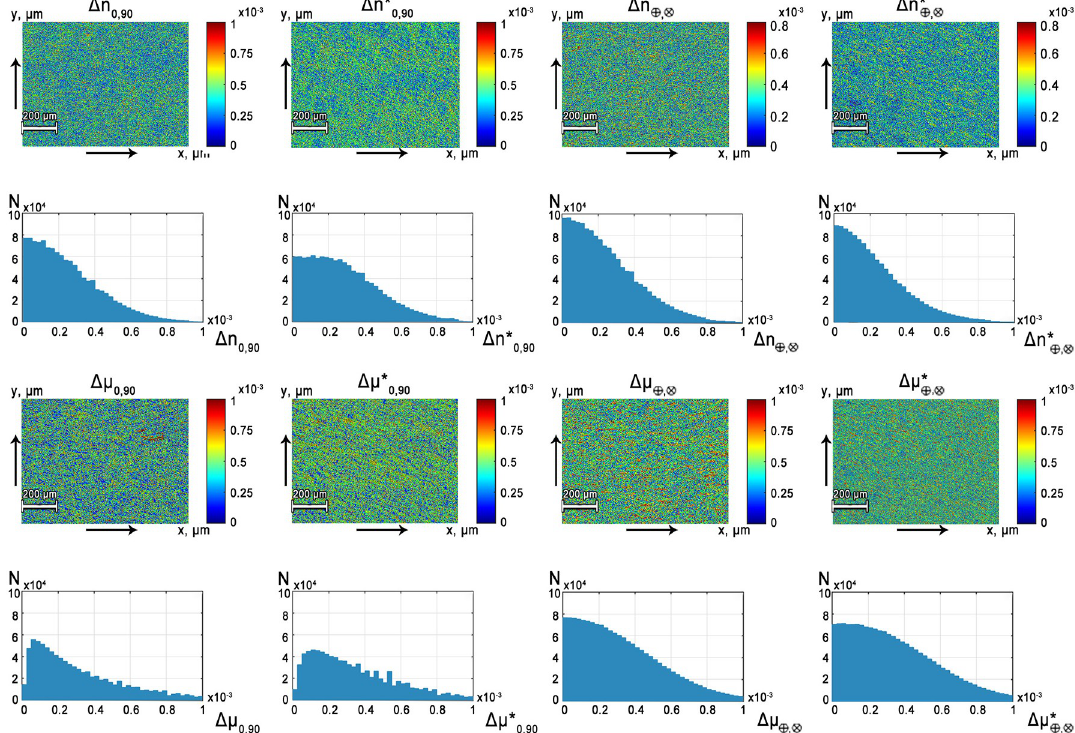
Fig 3. Polarization-phase spatial distribution PT( m × n ) and histograms N(PT) of the distributions F ( m × n )and A( m × n ) of myocardium histological sections of deceased patients from the group 1 ( Δ n 0;90 , Δ n � ; � , Δ μ 0;90 , Δ μ � ; � ) and the group 2 ( D n � D n � , D m � , D m � � ; � 0;90 � ; �